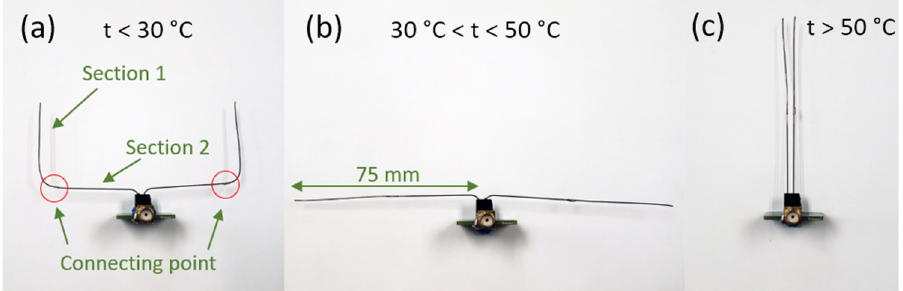
Figure 7. ShMoA under ( a ) no temperature crossing, t < 30 °C, ( b ) first temperature crossing event, 30 °C < t < 50 °C, and ( c ) the second temperature event, t > 50 °C.